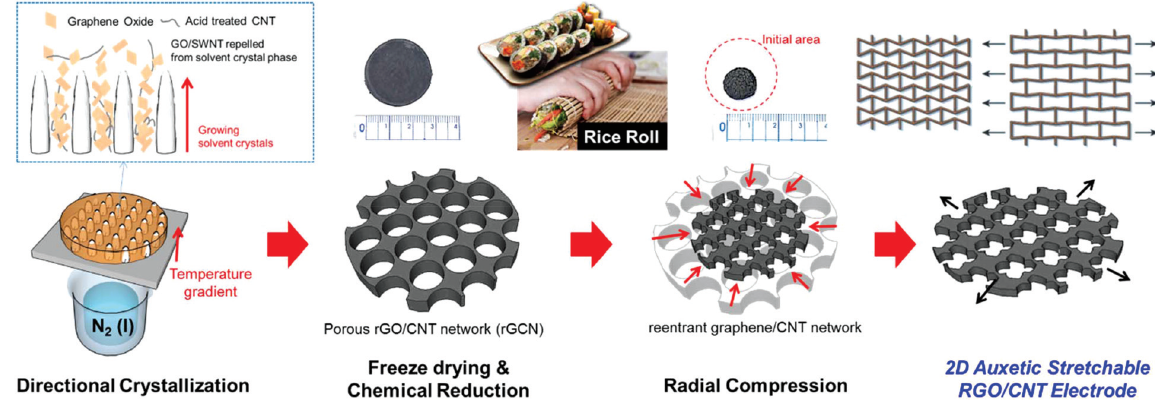
Figure 1: Schematic illustration of the fabrication process of two-dimensional (2D) auxetic reentrant graphene/CNT networks for omnidirec- tionally stretchable supercapacitor electrodes based on a directional freezing and radial compression process